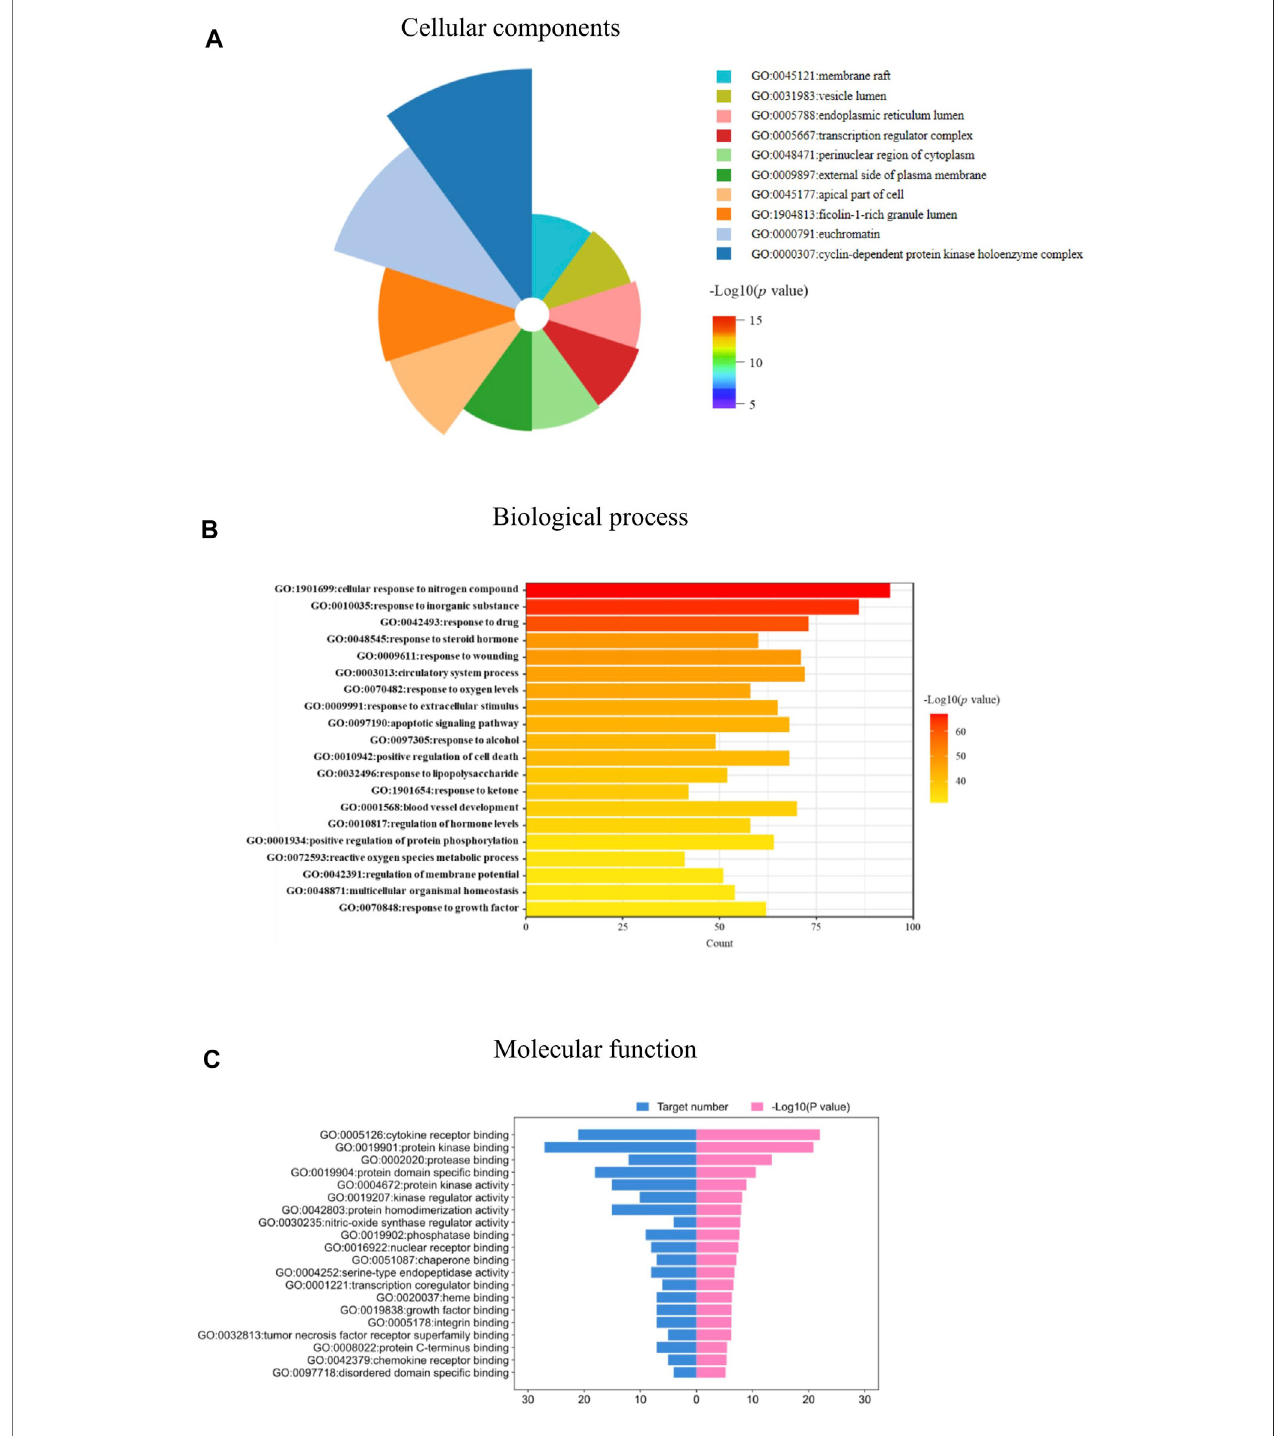
FIGURE 5 | biological function analysis of the overlapping targets. (A) Cellular components analyses. (B) Biological processes analyses. (C) Molecular function analyses related to JBOL treatment of IPF.